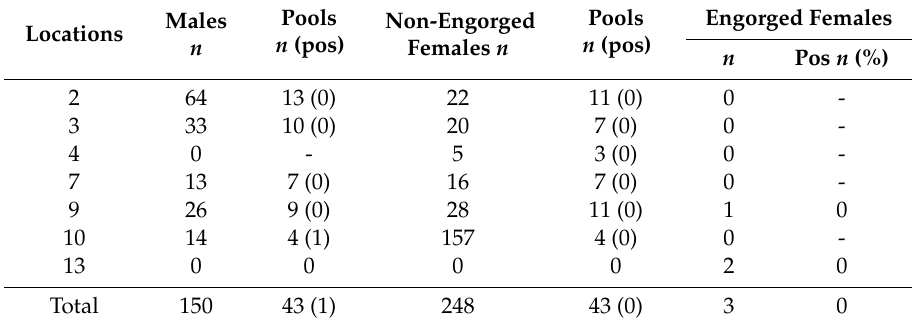
Table 2. Distribution of the Wutai mosquito phasivirus positive (pos) Aedes spp. pools according to the trapping locations.